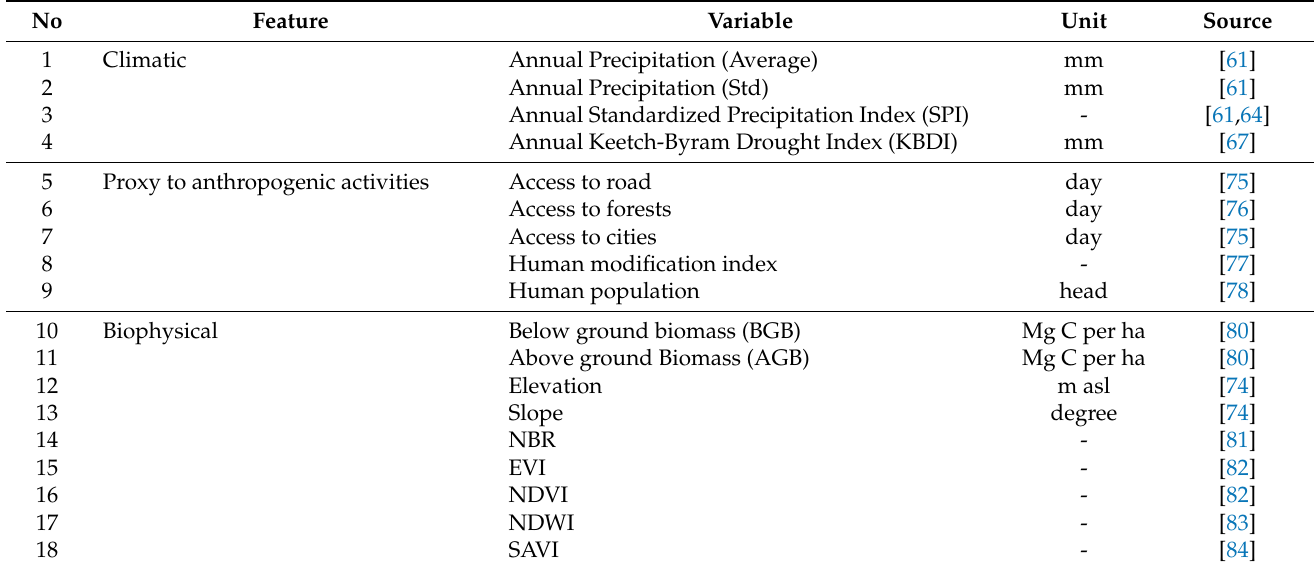
Table 2. Predictor used for the